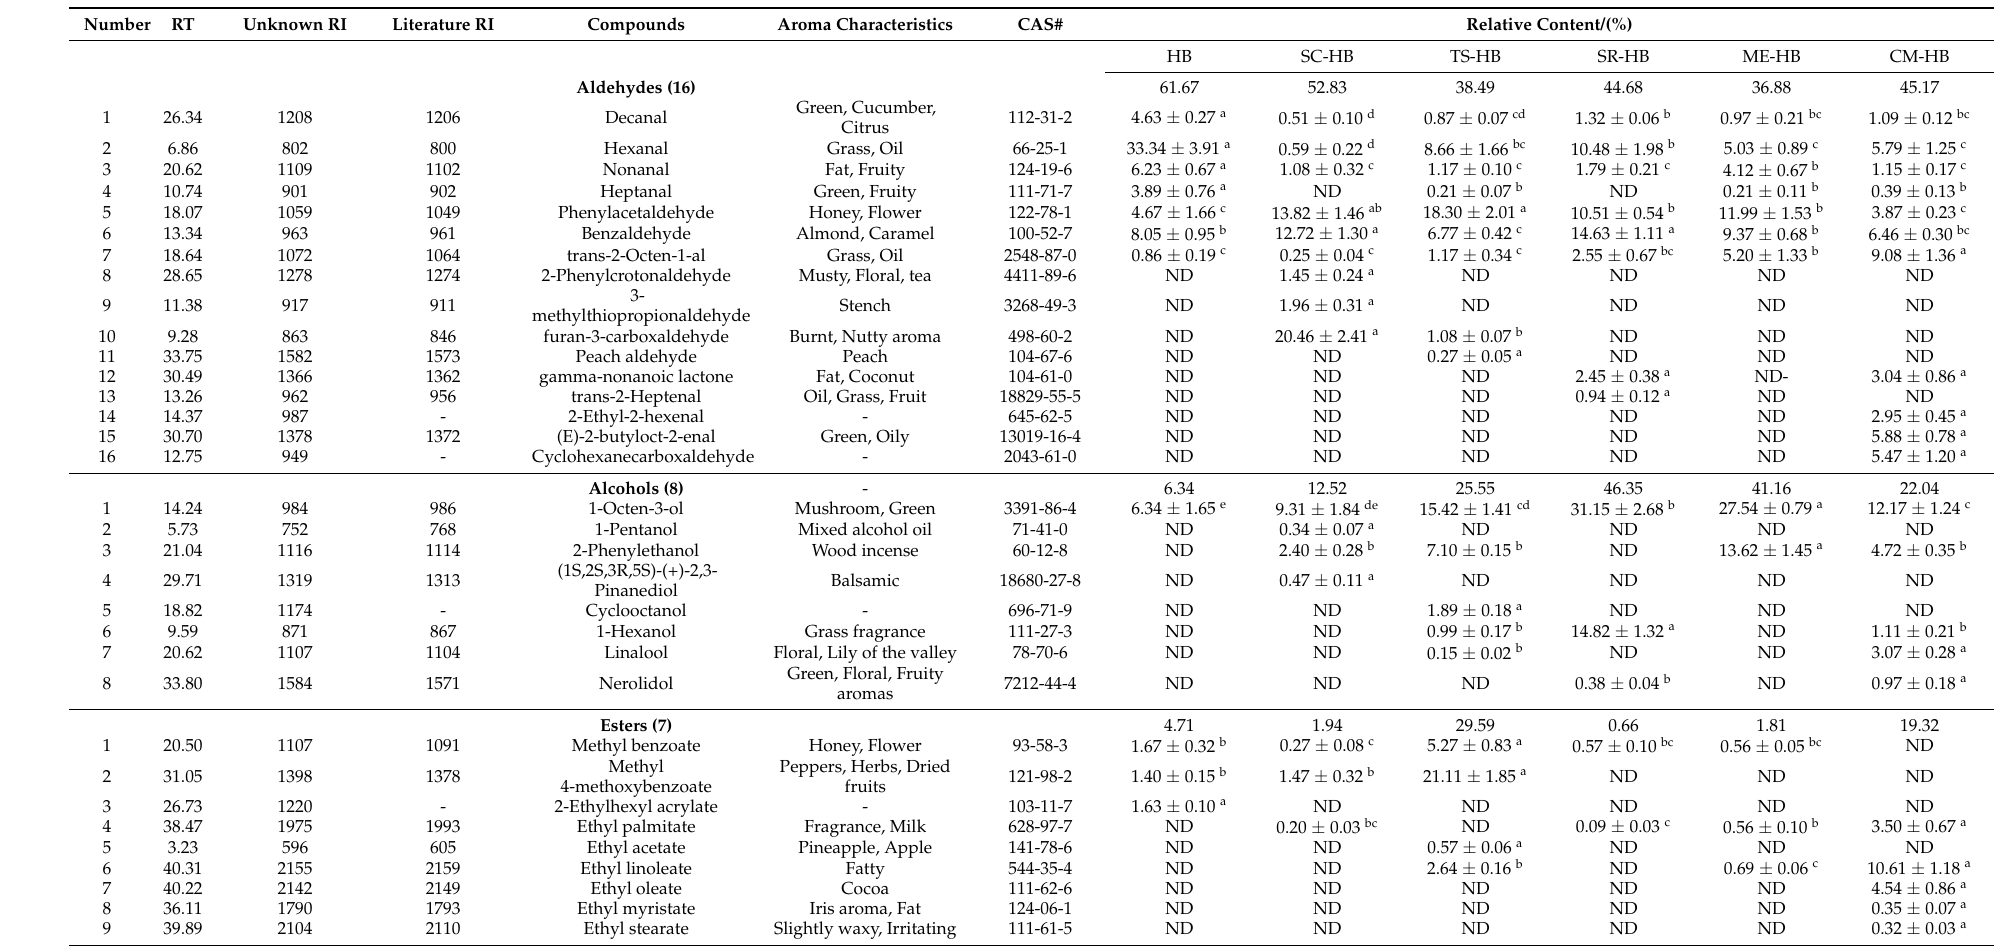
Table 1. Content of volatile compounds in original and fermented highland barley